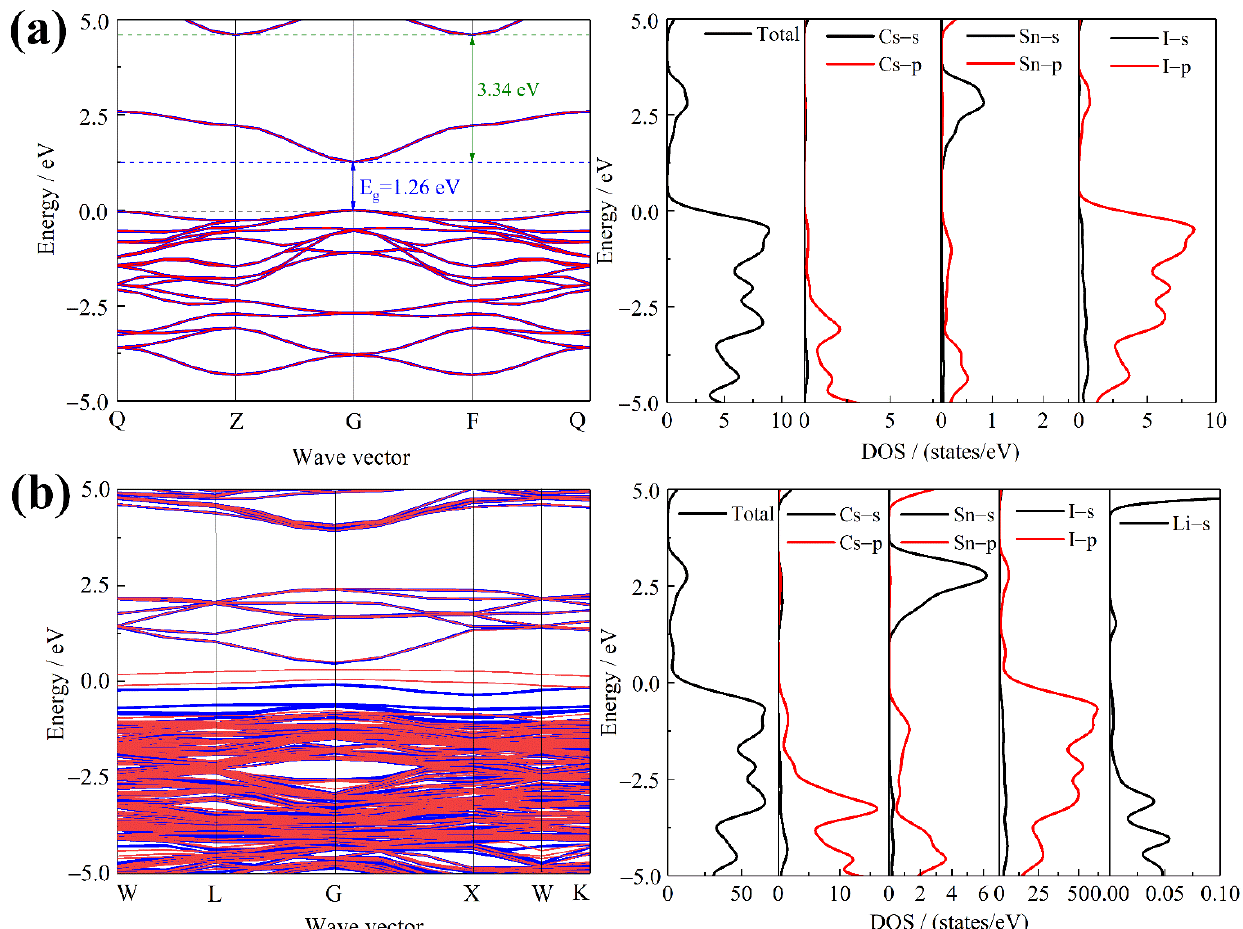
Figure 4. Band structure (red and blue lines are α and β spin polarization, respectively) and state density distribution of undoped and Li + interstitial doped Cs 2 SnI 6 , ( a ) undoped Cs 2 SnI 6, and ( b ) Li + interstitial doped Cs 2 SnI 6 .